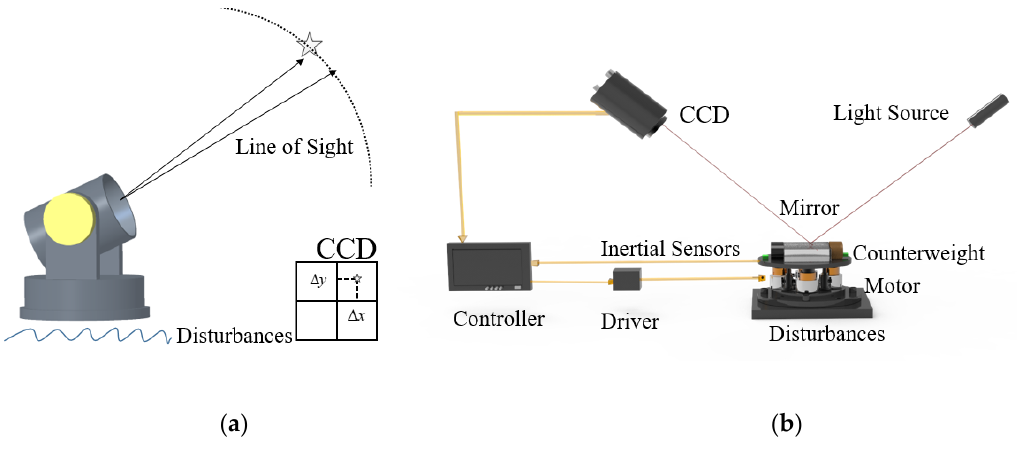
Figure 1. ( a ) A typical optical telescope; ( b ) Schematic diagram of fast stable platform.